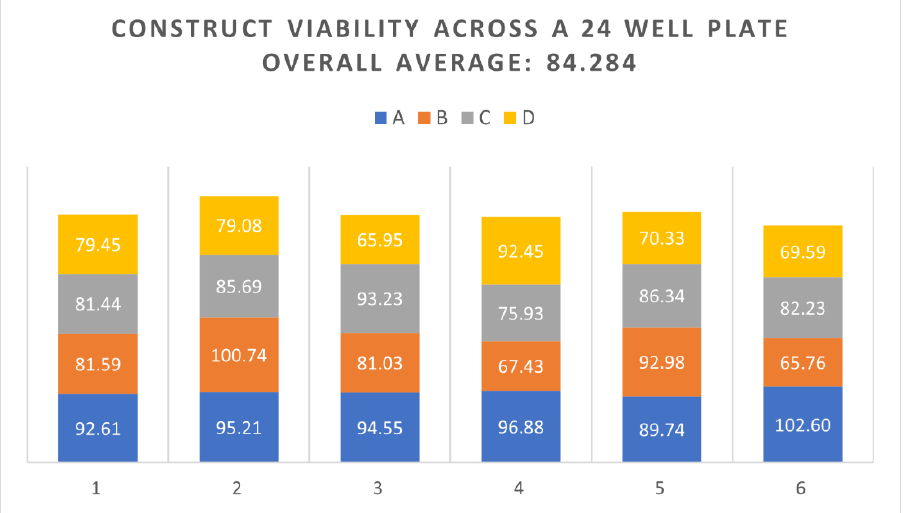
Figure 8. A full plate of EpiDerm constructs, 24, were vitrified and rewarmed using DP6/VS70. Viability was measured immediately after rewarming using the resazurin assay.